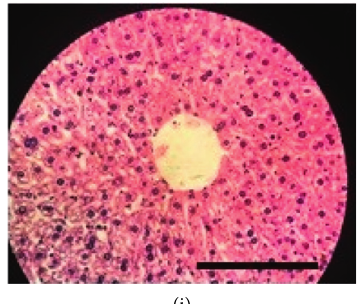
Figure 1: Histopathological changes in the liver. Each picture is a representative for each group as follows: (a) Normal control, (b) CCl4 control, (c) CCl4+ 2.6ml/kg/day Holyliv, (d) CCl4+ 5.2ml/kg/day Holyliv, (e) CCl4+ 2.6ml/kg/day Heptaliv, (f) CCl4+ 5.2ml/kg/day Heptaliv, (g) CCl4+ 2.6 ml/kg/day Icturn, (h) CCl4+ 5.2ml/kg/day Icturn, (i) CCl4+ 2.6ml/kg/day J-Deenar, (j) CCl4+ 5.2 ml/kg/day J- Deenar. Each group was assessed at 400X magnification, Scale bar: 40 μ m. CV � central vain, black arrow pointed the infiltration of inflammatory cells